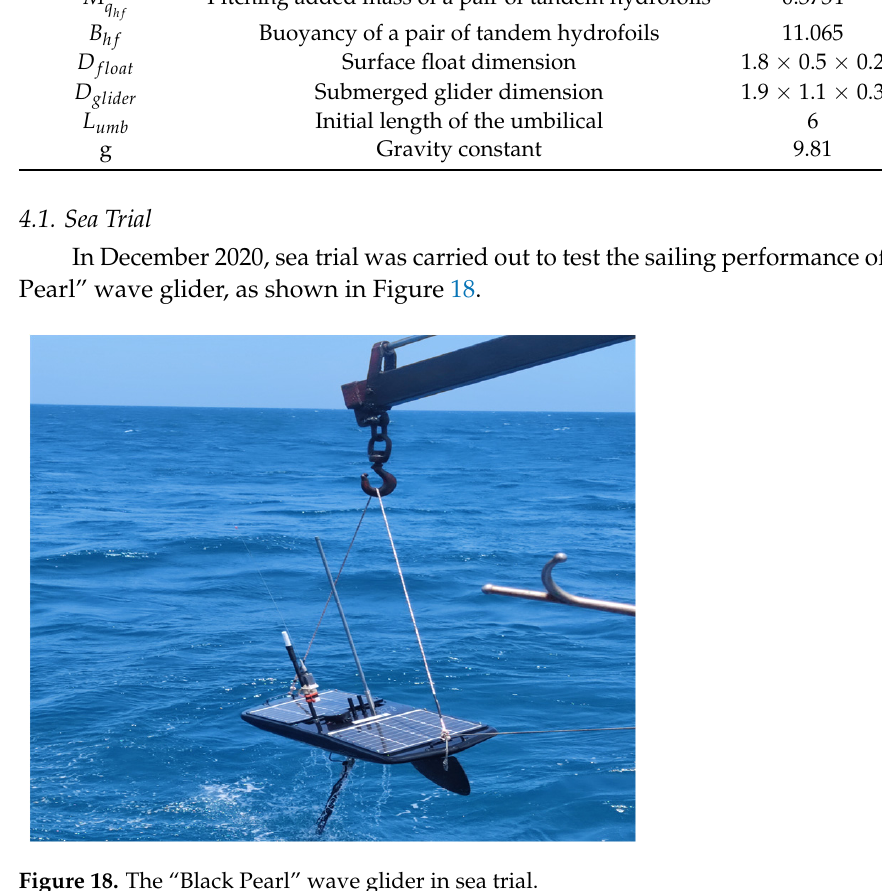
Figure 19. The trajectory of the wave glider. The sea conditions during the sea trial from T2 to T1 were obtained by using a wave sensor; wave data are shown in Figure 20a. Moreover, the real-time values and the moving average value of the pitching angle of the submerged glider are shown in Figure 20b. It can be seen that the average speed of the wave glider increases correspondingly with the continuous increase of significant wave periods and wave heights. Moreover, the average pitching angle and the pitching angle amplitude of the submerged glider both increase slightly.